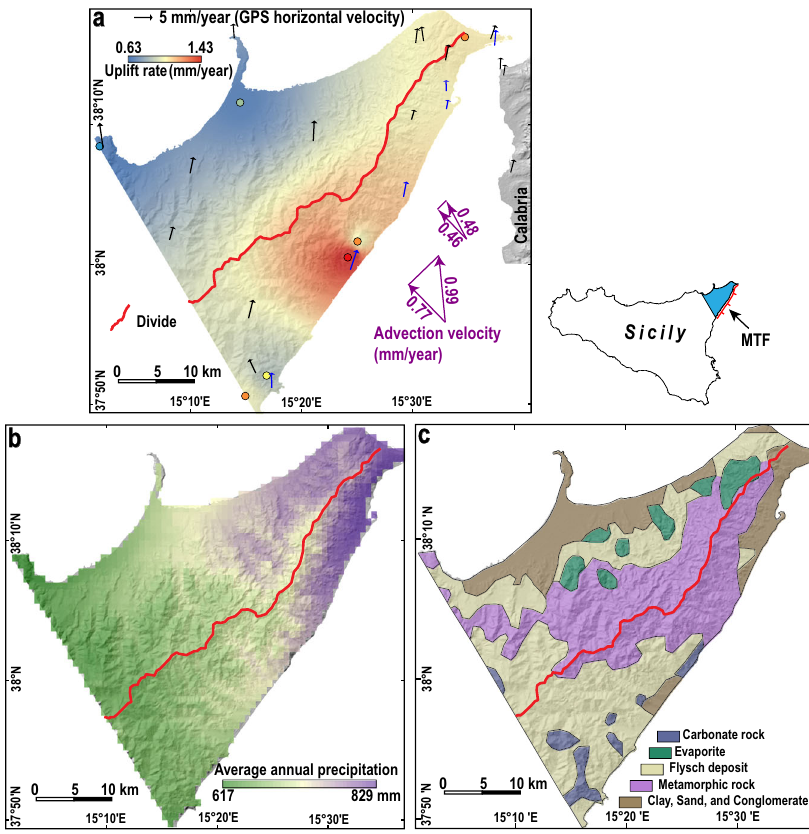
Fig. 5 Natural example of Northeastern Sicily. a Uplift rates integrated since the Late Pleistocene (data from ref. 47 ). Black and blue arrows indicate GPS horizontal velocities in a fi xed central Europe frame 48 . See “ Methods ” for the details on the estimation of advection velocity. b Average annual precipitation between 1970 and 2000, acquired from WorldClim 49 . c Lithology of Northeastern Sicily (modi fi ed after ref. 50 ). MTF: Messina-Taormina Fault (modi fi ed after ref. 45